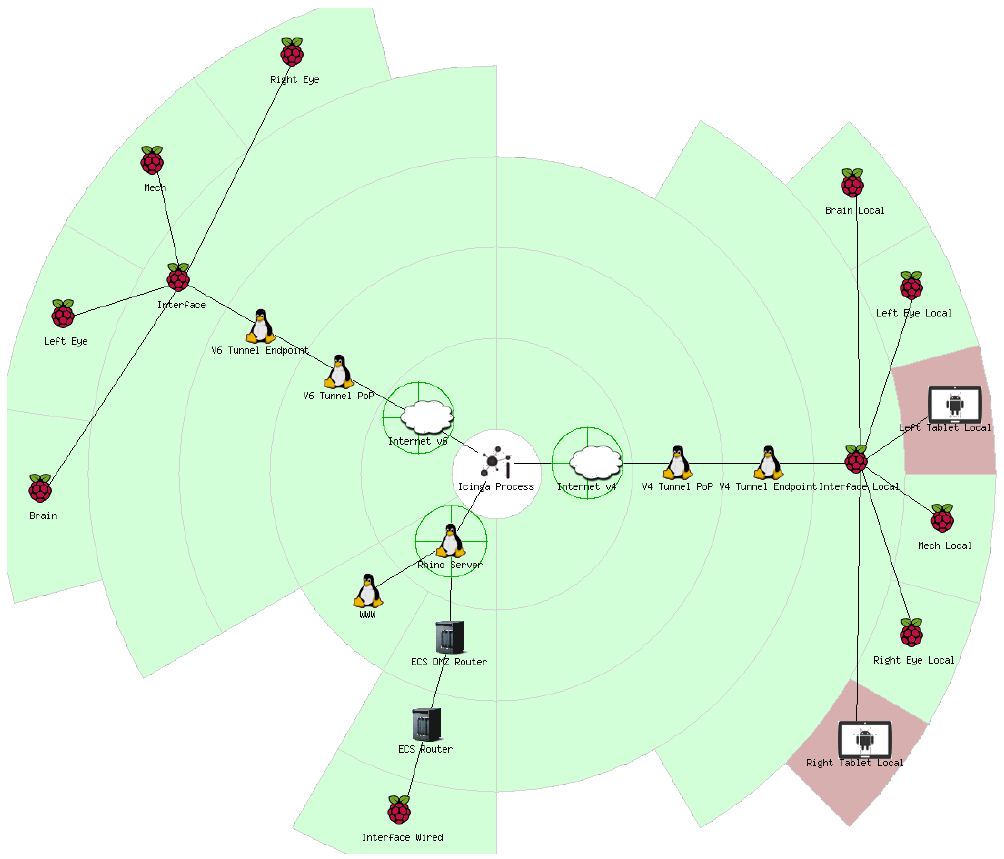
Figure 5. Example output from Erica’s status monitoring, showing her current hardware as detailed in Section